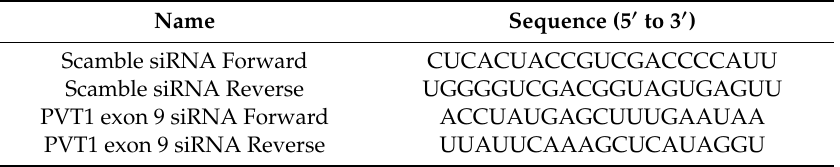
Table 1. Sequence of PVT1